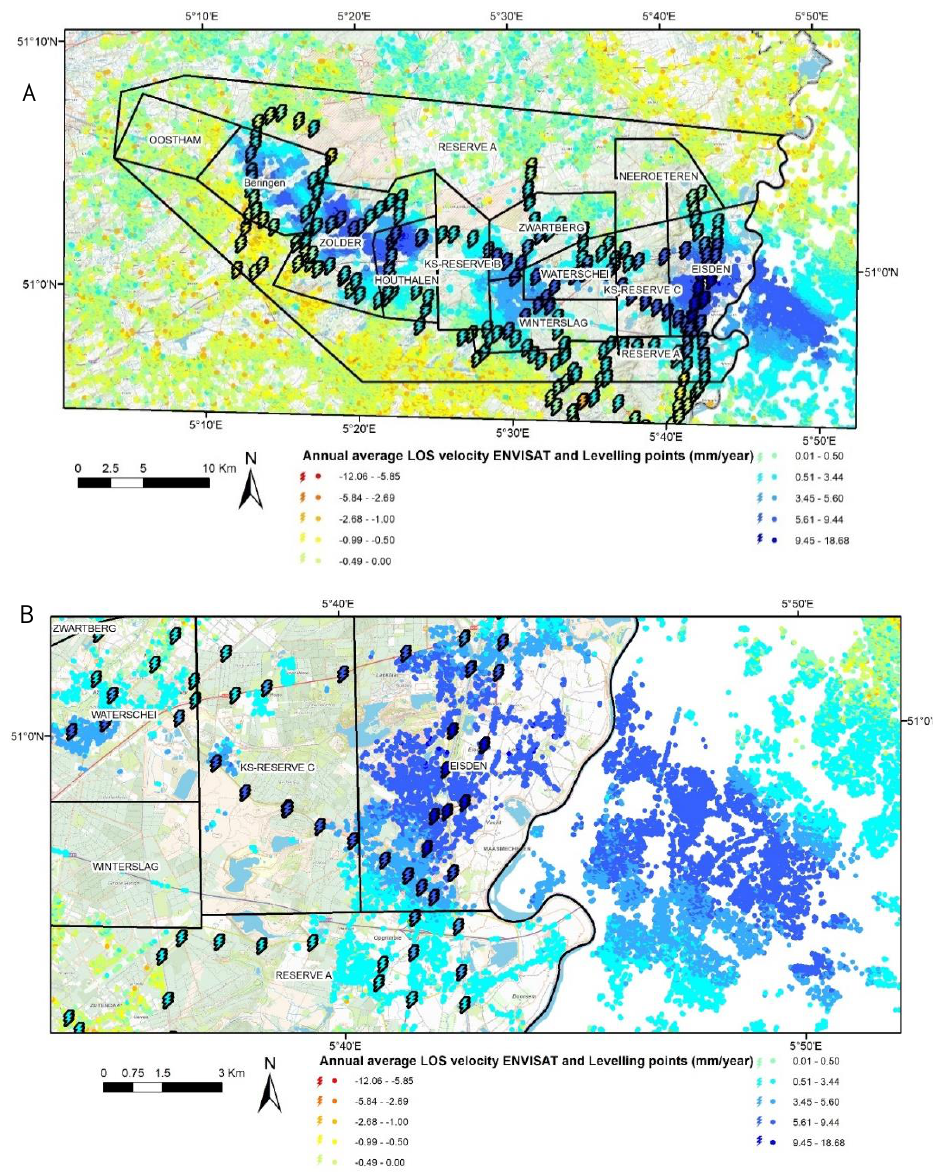
Figure 17. ( A ) Vertical velocity of the leveling measurements vs. the annual average LOS velocity values of the PS. ( B ) Close up of the vertical velocity of the leveling measurements vs. the annual average LOS velocity values of the PS.